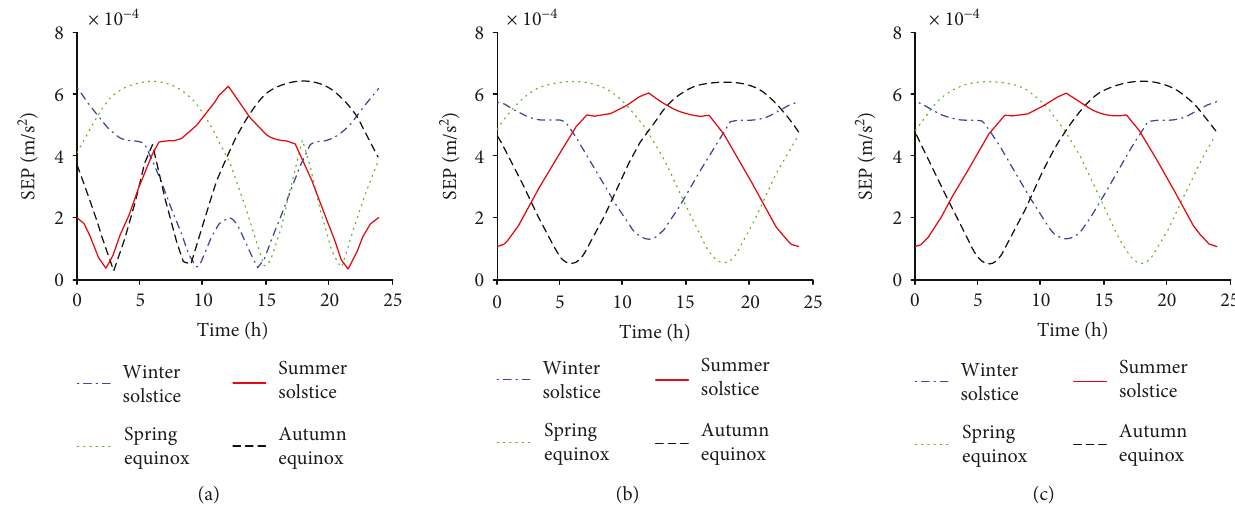
Figure 4: Strict formation on ideal displaced GEO for the hybrid sail case: acceleration provided by SEP (a) leader, (b) follower 1, and (c) follower 2 in the frame (A).